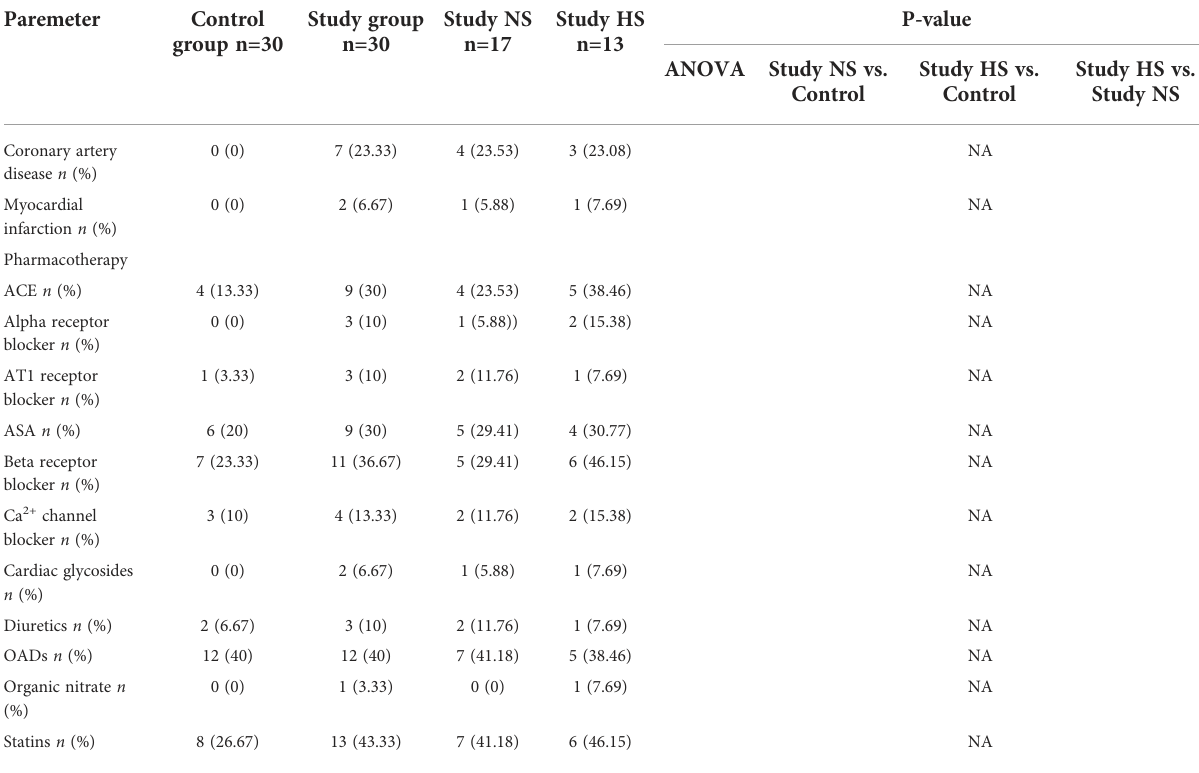
Bold indicates statistically signi fi cant results. NA, non applicable.